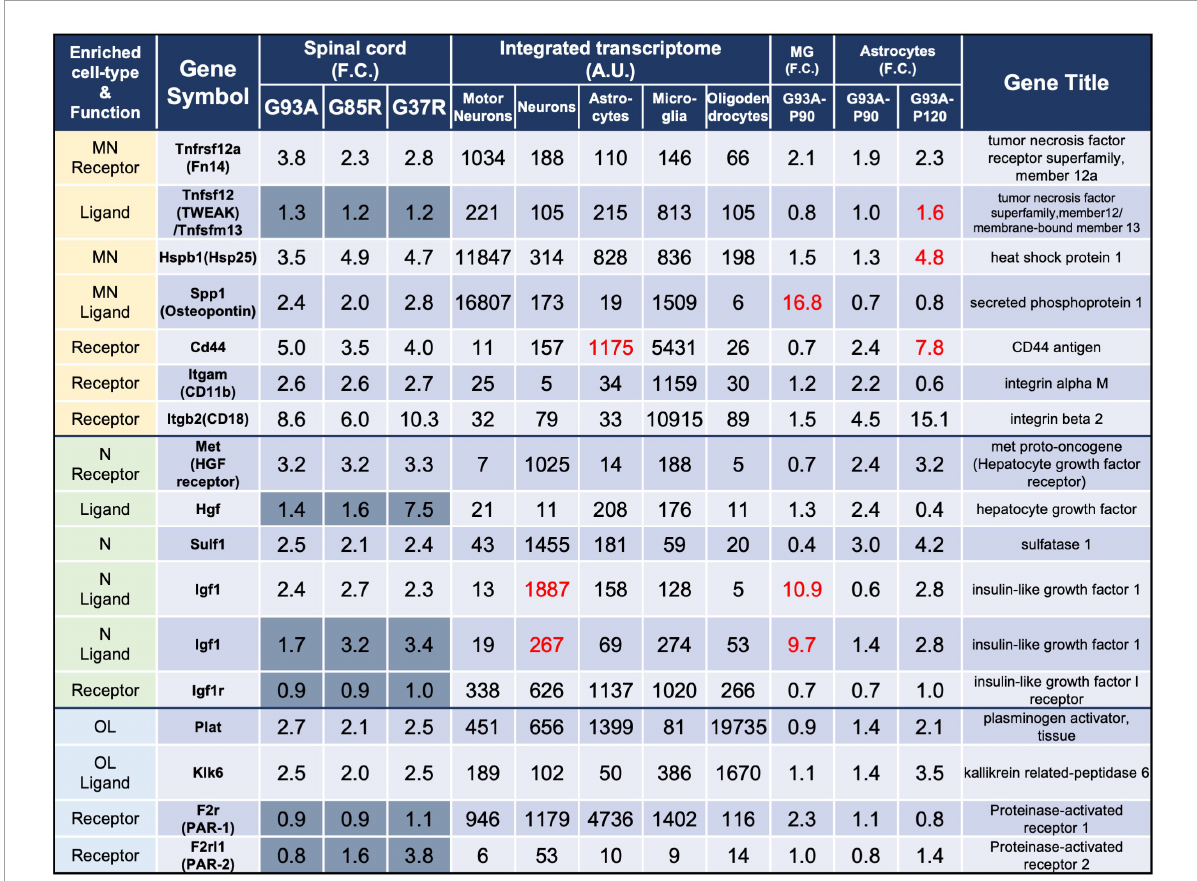
FIGURE3 Representative motor neuron-enriched genes, neuron-enriched genes, and oligodendrocyte-enriched genes in 207 DEGs were analyzed using the integrated transcriptome and SOD1 G93A cell-type transcriptome. The 3rd to 5th columns show the fold changes in each gene expression in SOD1 G93A , SOD1 G85R , and SOD1 G37R mouse spinal cords compared to control samples, respectively. Genes with dark gray backgrounds in the 3rd to 5th columns that indicate fold changes (F.C.) are not included in the 207 DEGs. The 6th to 10th columns show the integrated transcriptome. The 11th column shows the fold change in expression of each gene in P90 SOD1 G93A microglia relative to control microglia. The 12th to 13th columns show the fold change in expression of each gene in SOD1 G93A astrocytes (P90 or P120) relative to control astrocytes. MN, motor neurons; N, neurons; MG, microglia; OL,